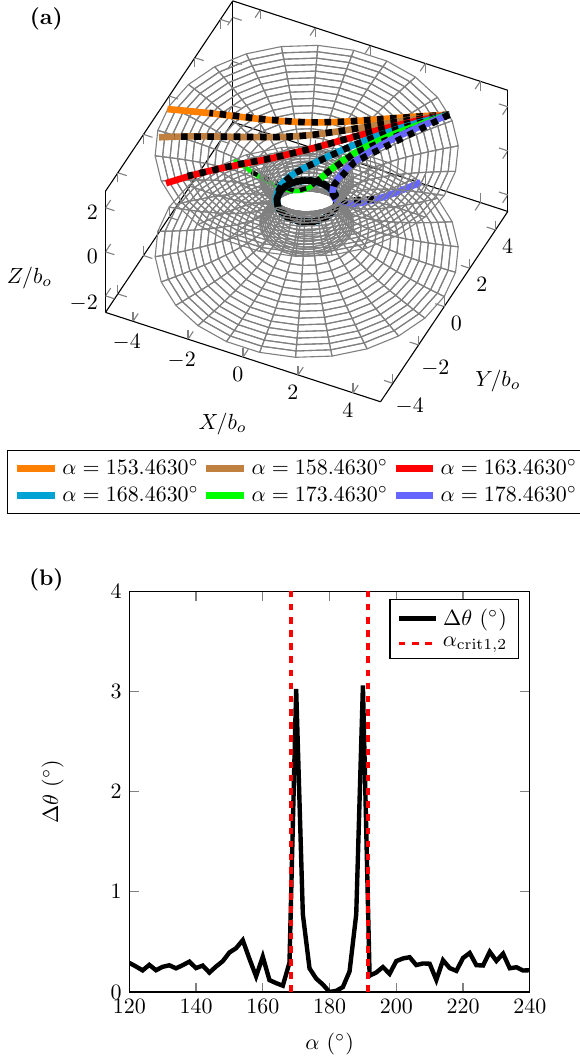
Fig. 5 Simulation results for an Ellis WH: b 0 = 1, R i = 5 r s , φ i = 45 ◦ , and (cid:14)μ max = 10 − 2 b 0 . Panel a : Geodesics generated for different emission angles α . Solid color are results obtained with the proposed algorithm and black dashed lines are results obtained from the orbital equation. Panel b : Angular deviation versus emission angle α inside the range: 120 ◦ − 240